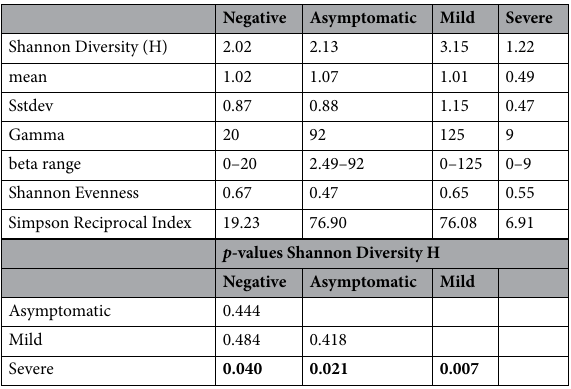
Table 2. Microbiome diversity in COVID-19 cohorts. Significant values are in [bold].